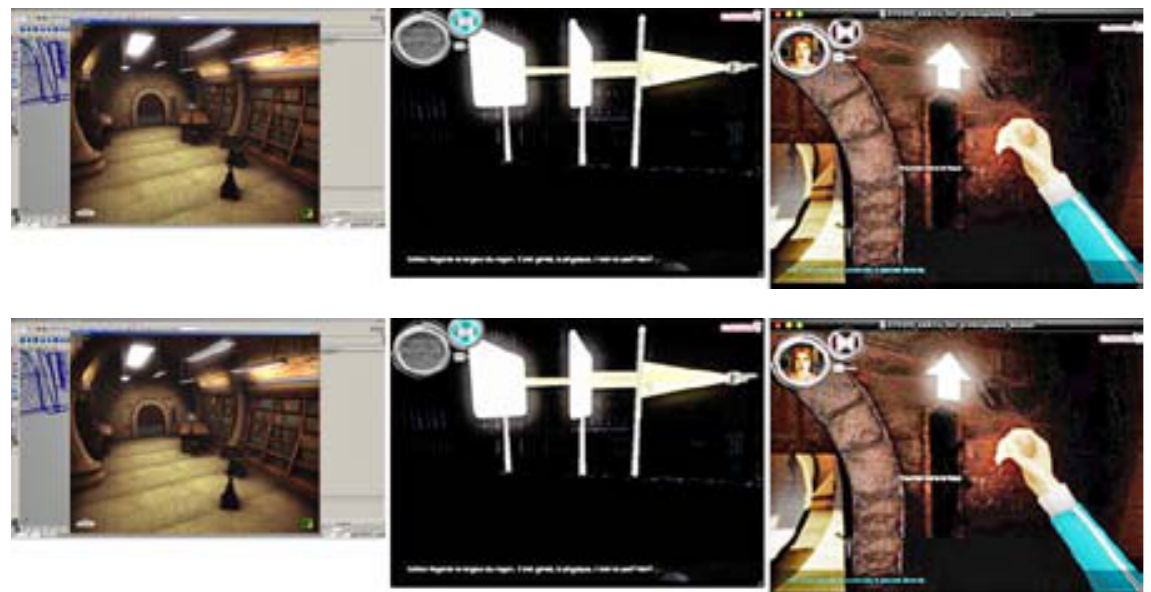
Figure 1. Conventional design of Elektra without support. The second design condition (G_ES) is similar to the first in that no support is given. Rath - er, descriptions of the relevant learning concepts are presented in a separate hyperlinked textbook. The learners are made aware of the support device that is always available by a permanently visible button with a hyperlink to the textbook (see Figure